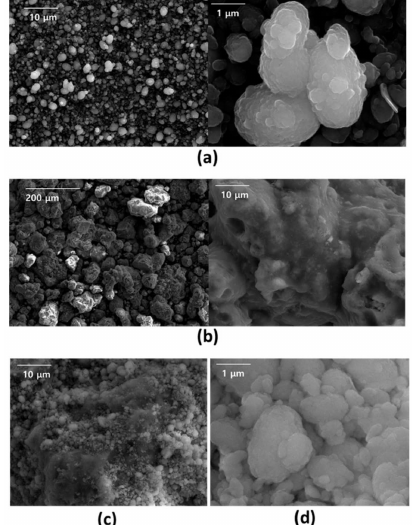
Figure 1. X-ray di ff raction (XRD) patterns of ( a ) HZSM-48, ( b ) Pt / (HZSM-48 + pseudoboehmite, 1:1), ( c ) Pt / (HZSM-48 + pseudoboehmite, 1:2), ( d ) spent catalyst of Pt / (HZSM-48 + pseudoboehmite, 1:1), ( e ) pseudoboehmite.